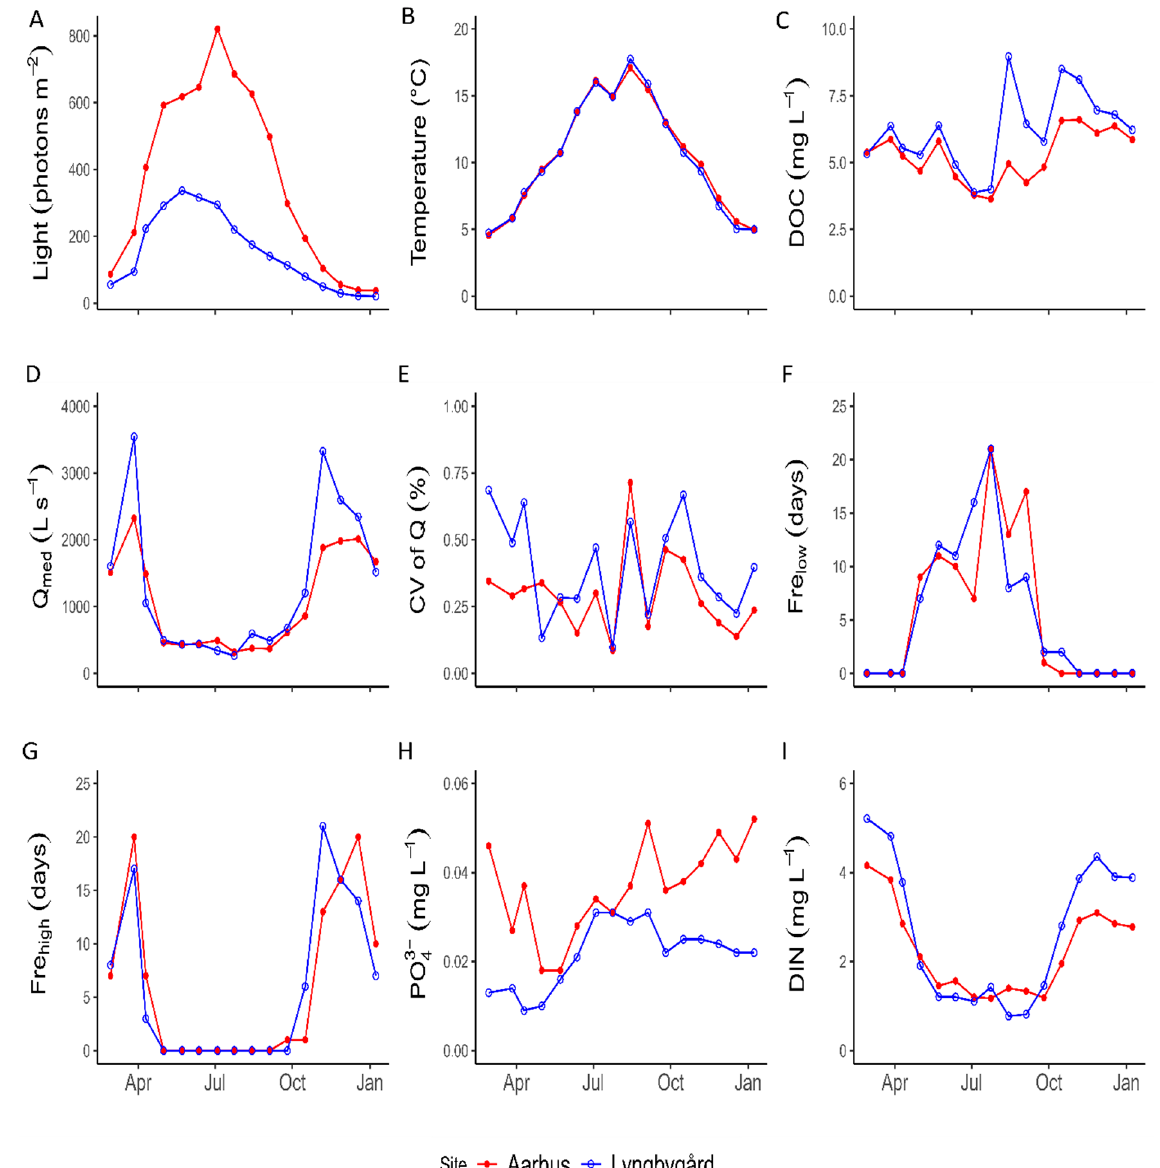
Figure 1. Changes in environmental variables over the study period. Description of calculations of these variables can be found in Table S1. All environmental data derived from measurements obtained in the period of 21 days before the sampling date: ( A ): cumulative light (Photons m − 2 day − 1 ); ( B ): mean temperature ( ◦ C); ( C ): mean DOC (mg L − 1 ); ( D ): median discharge (Q med , L s − 1 ); ( E ): coefficient of variation of discharge (CV of Q, %); ( F ): frequency of low flow (Fre Low , days); ( G ): frequency of high flow (Fre High , days); ( H ): mean PO 4 3 − concentration (mg L − 1 ) in water and ( I ): mean DIN concentration (mg L − 1 ) in